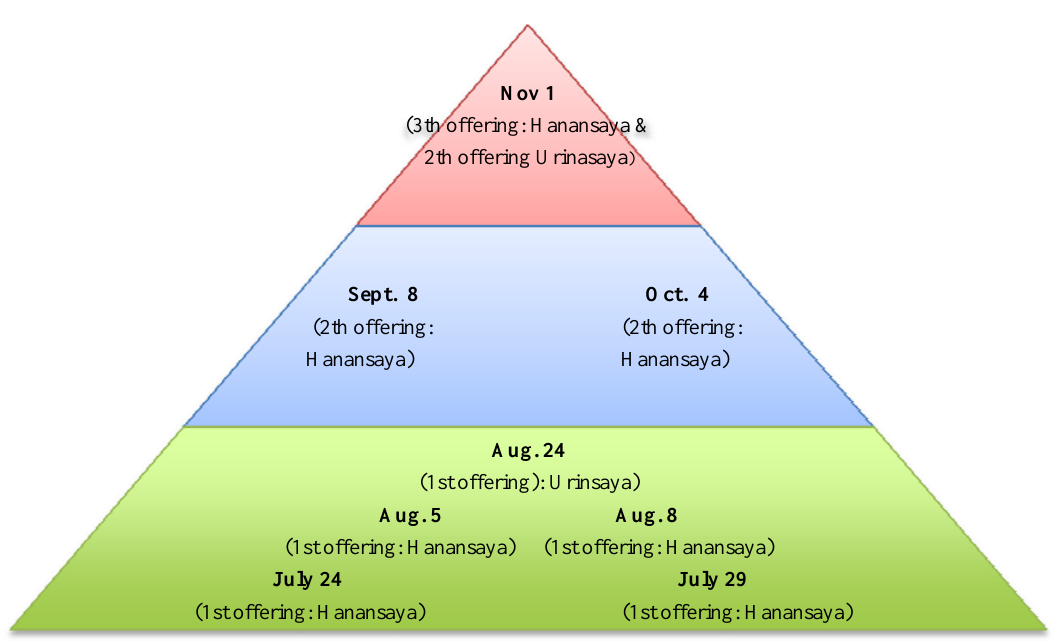
Figure 1. Model of offerings in